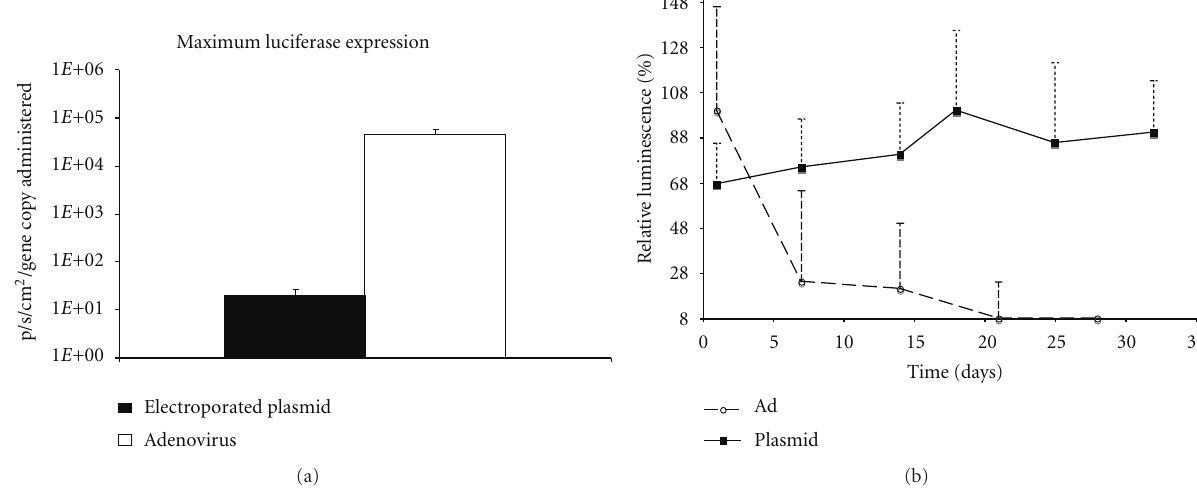
Figure 3: Adenoviral vector and electroporated plasmid-mediated transgene expression in vivo. Thighs of mice were in vivo administered pCMV-luc by electroporation or AdCMV-luc ( n = 5). Luminescence was analysed in vivo over time using IVIS live whole body imaging. (a) Magnitude of electroporated plasmid-mediated luciferase expression compared with Ad-mediated expression (day 18 and day 1, resp.). (b) Plasmid versus Ad transgene expression over time. Although luminescence was higher with Ad delivery, it was subject to rapid silencing to background levels by day 21, unlike electroporated plasmid.